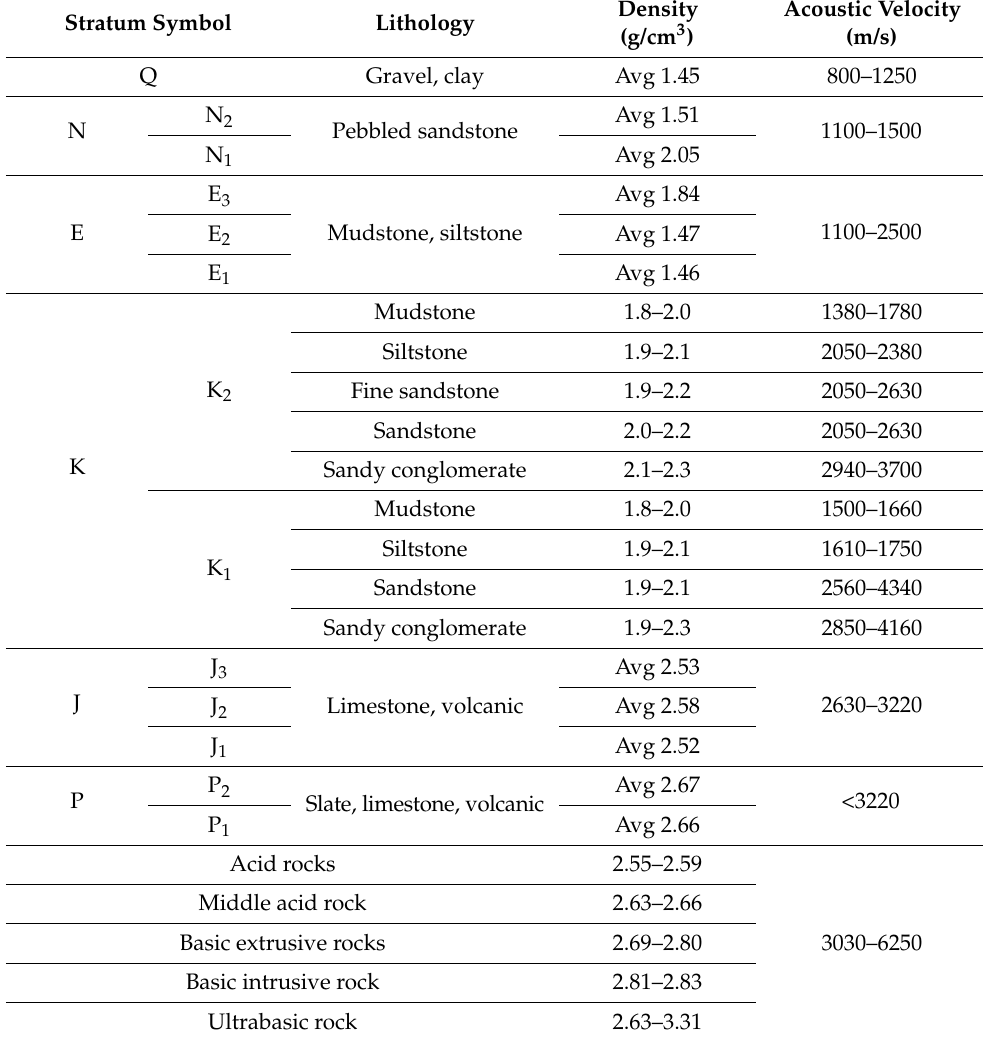
Table 1. The physical parameters of formations and rocks in Erlian basin (modified from Wu et al. [54]). Stratum Symbol Lithology